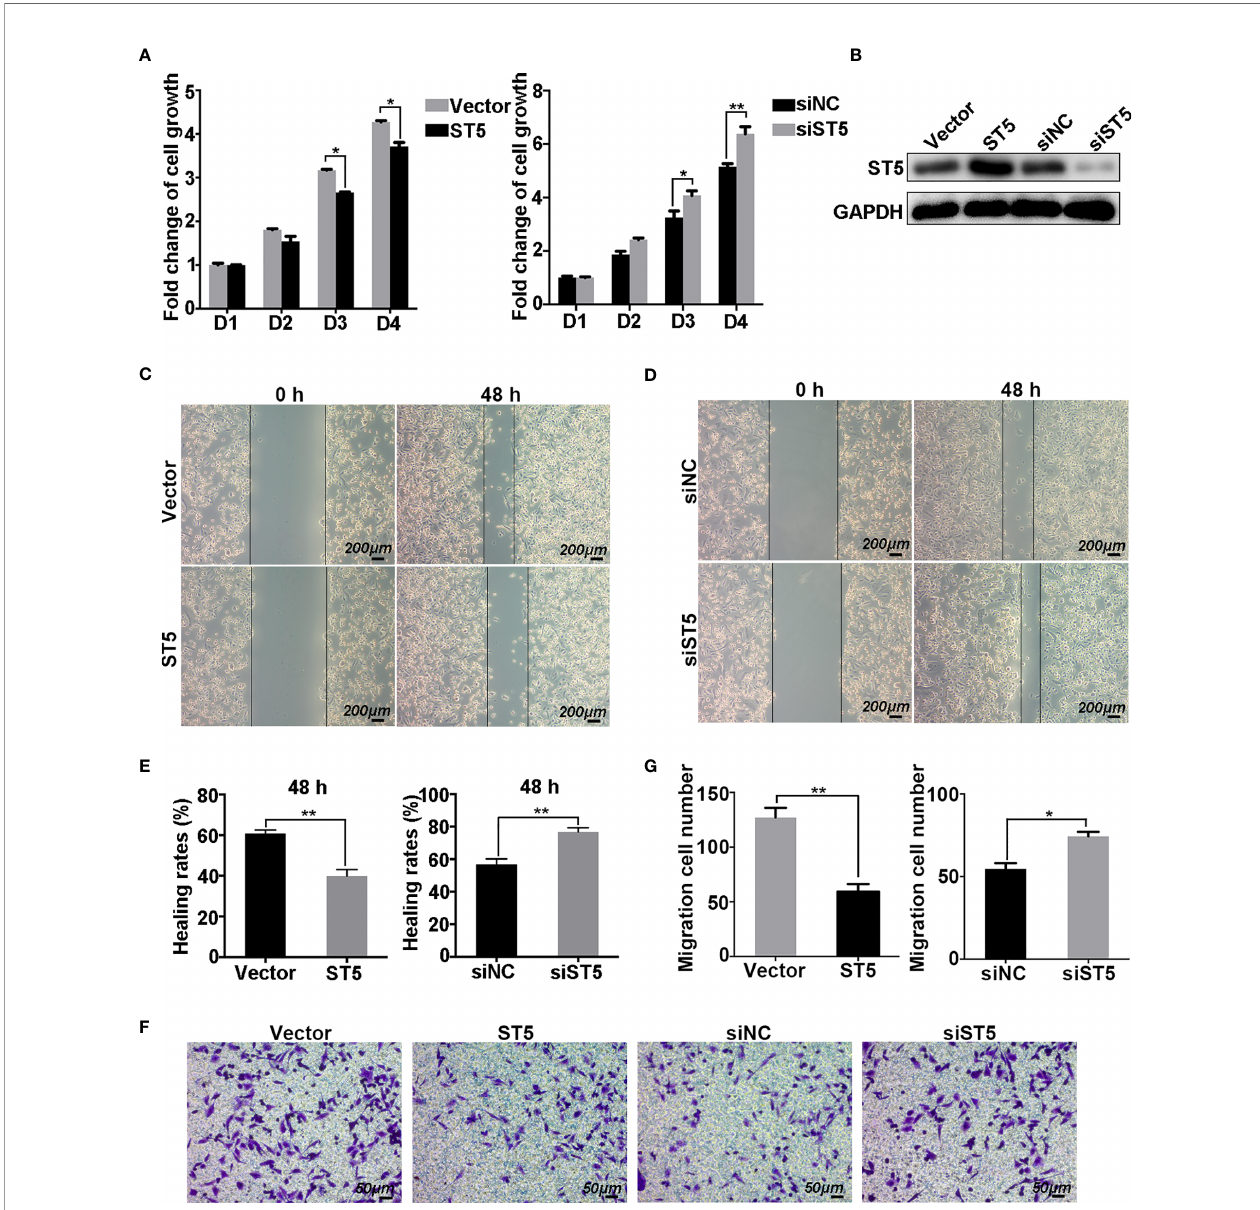
FIGURE 3 | Effect of ST5 on cell proliferation and migration of MDA-MB-231 cells. MTT assay was performed to measure the growth ability of MDA-MB-231 cells transfected with control plasmid (Vector) and ST5-overexpressing plasmid (ST5) and MDA-MB-231 cells transfected with negative control siRNA (siNC) and siRNA targeting ST5 (siST5) (A) . (B) The veri fi cation of transfection ef fi ciency of ST5 overexpressing plasmid or knockdown siRNA as detected by Western Blotting. Images of wound healing in Vector and ST5 group (C) , siNC and siST5 group (D) before and after wound healing for 48 h Scale bar, 200 m m. (E) Healing rates in MDA-MB-231 cells transfected with Vector, ST5, siNC or siST5 as analysed by using Image Pro Plus software (version 6.0). (F) Cell migration was determined using Transwell assay and the migrated cells were stained by 0.1% crystal violet for 20 minutes. Scale bar, 50 m m. (G) The number of cells migrated to the lower chamber as calculated by using Image Pro Plus software. * indicated cells transfected with ST5-overexpressing plasmid or siST5 vs . Vector or siNC, respectively. *P < 0.05; **P <